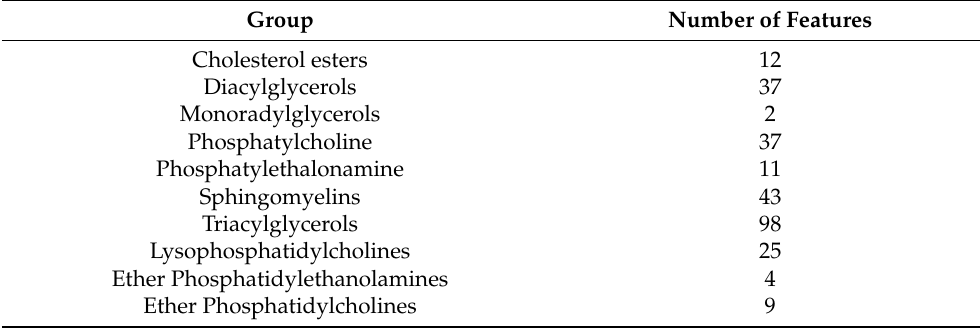
Table 2. Grouped features according to their super class; ION C18 positive mode